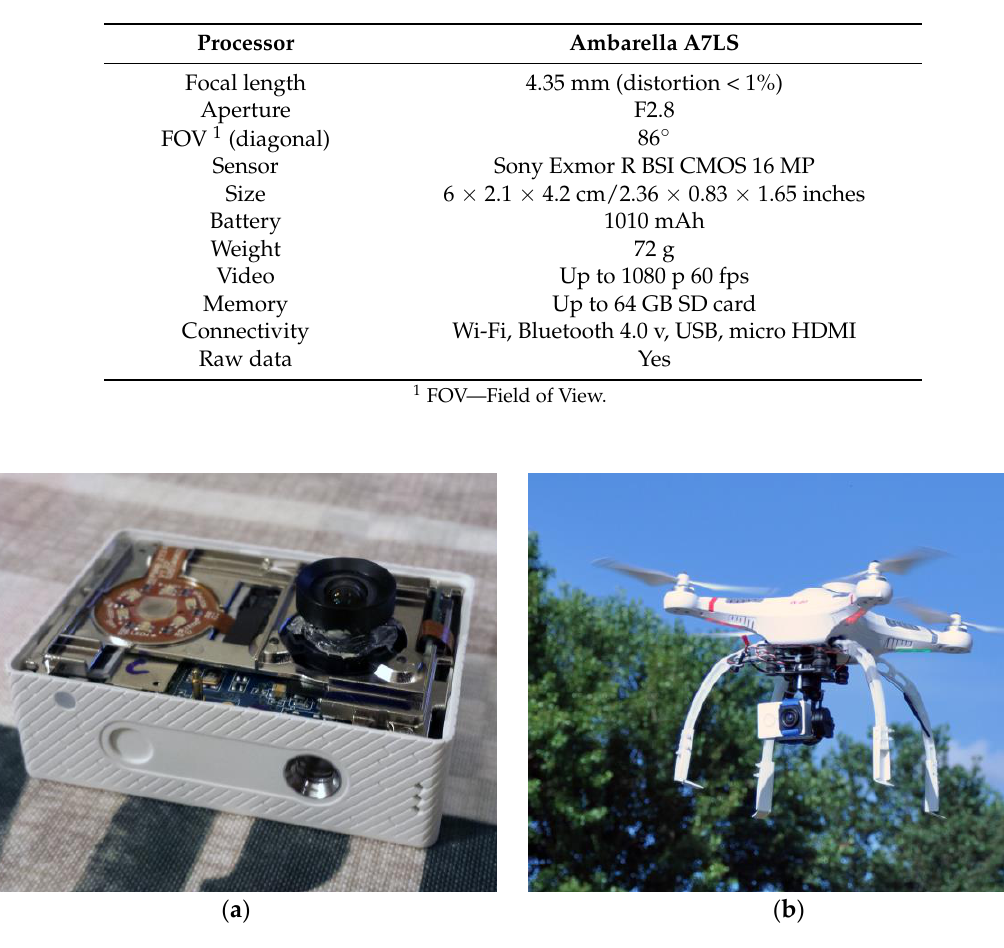
Figure 1. A Xiaomi Yi action camera; ( a ) in improving phase; ( b ) on a 3-axes gimbal on an Unmanned Aerial Vehicle (UAV).